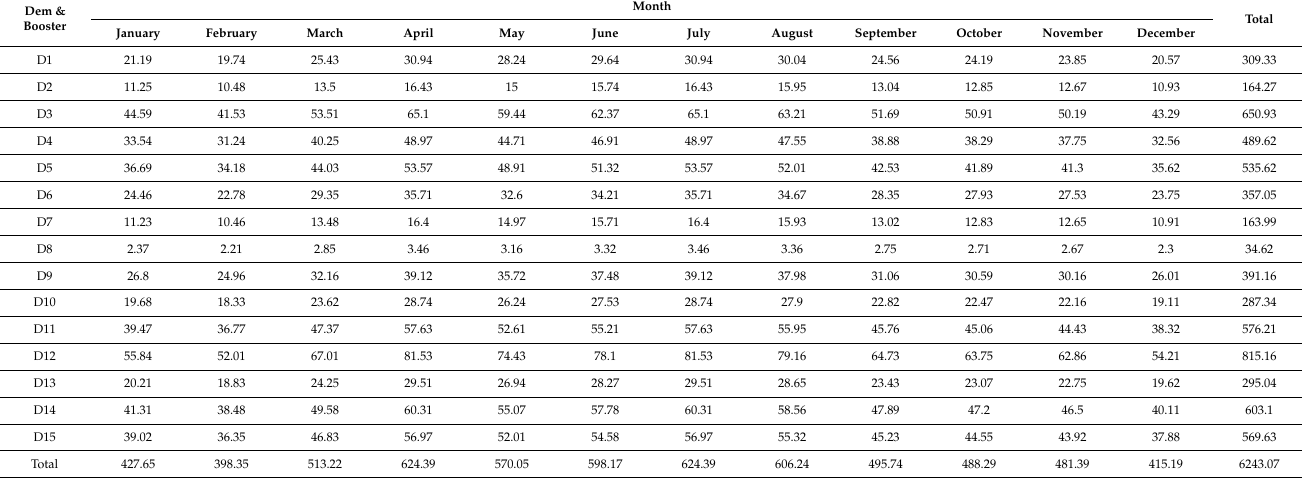
Table 5. Water Requirement for agricultural nodes (M.m 3 /month)